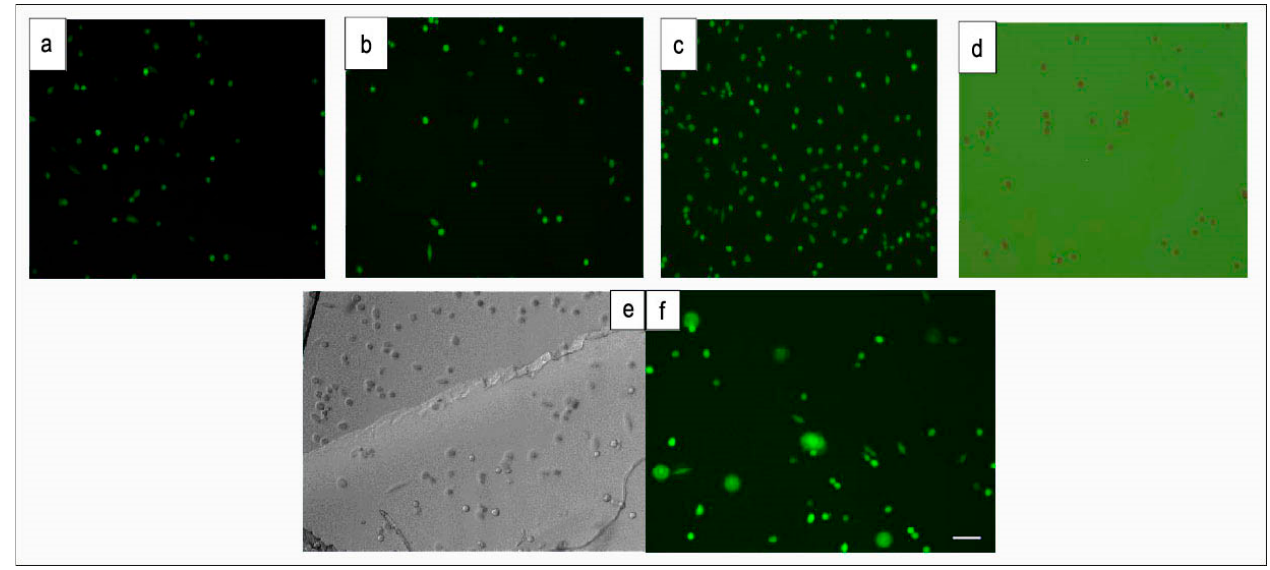
Figure 2. Fluorescent images of cells test by live/dead cell assay with L929 after incubated for 24 h. ( a ) Control cells; ( b ) EB; ( c ) EY; ( d ) EB 0.1% with PEG-DA; ( e ) optical micrograph of cross-linked EB/PEG-DA hydrogel; ( f ) fluorescence image of cross-linked EB/PEG-DA hydrogel. Scale bar depicts 50 µm.